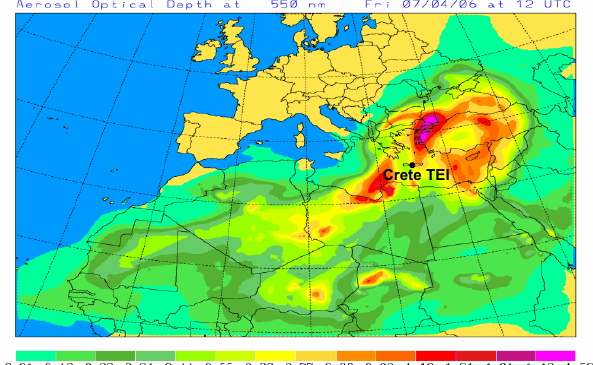
Fig. 2. AOD at 550nm from the SKIRON/Dust model on 7 April 2006. The location of the measuring station in Crete is marked in the figure.